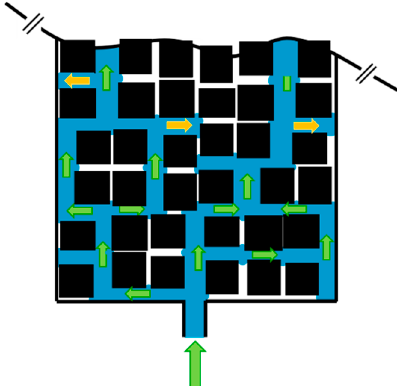
Figure 1. Schematic illustration of the impact of the pore structure on the transport properties. Solid spaces are indicated in black and pore spaces are indicated in white and blue, depending on the saturation with wetting and non-wetting phases. The blue phase (which is the wetting phase here) finds pathways through the larger connected pores (indicated by the green arrows), whereas stagnation (orange arrows) occurs in dead ends. The small pores remain uninvaded (shown in white).